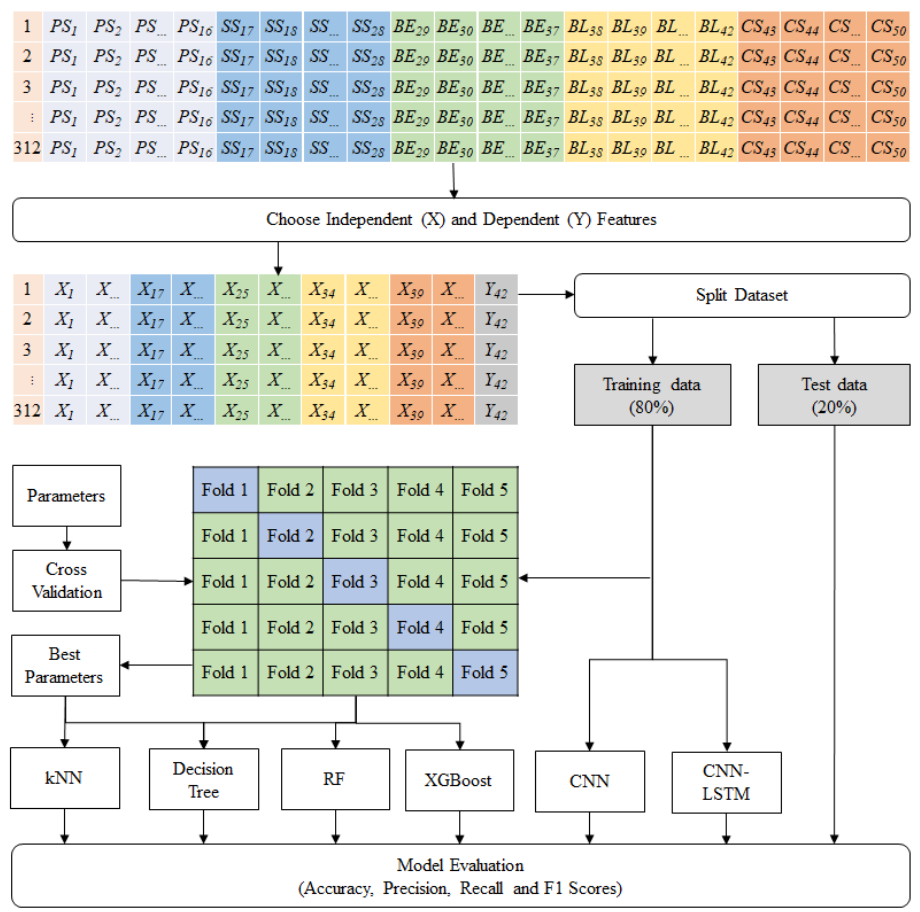
Figure 5. The overall flow of model training process.